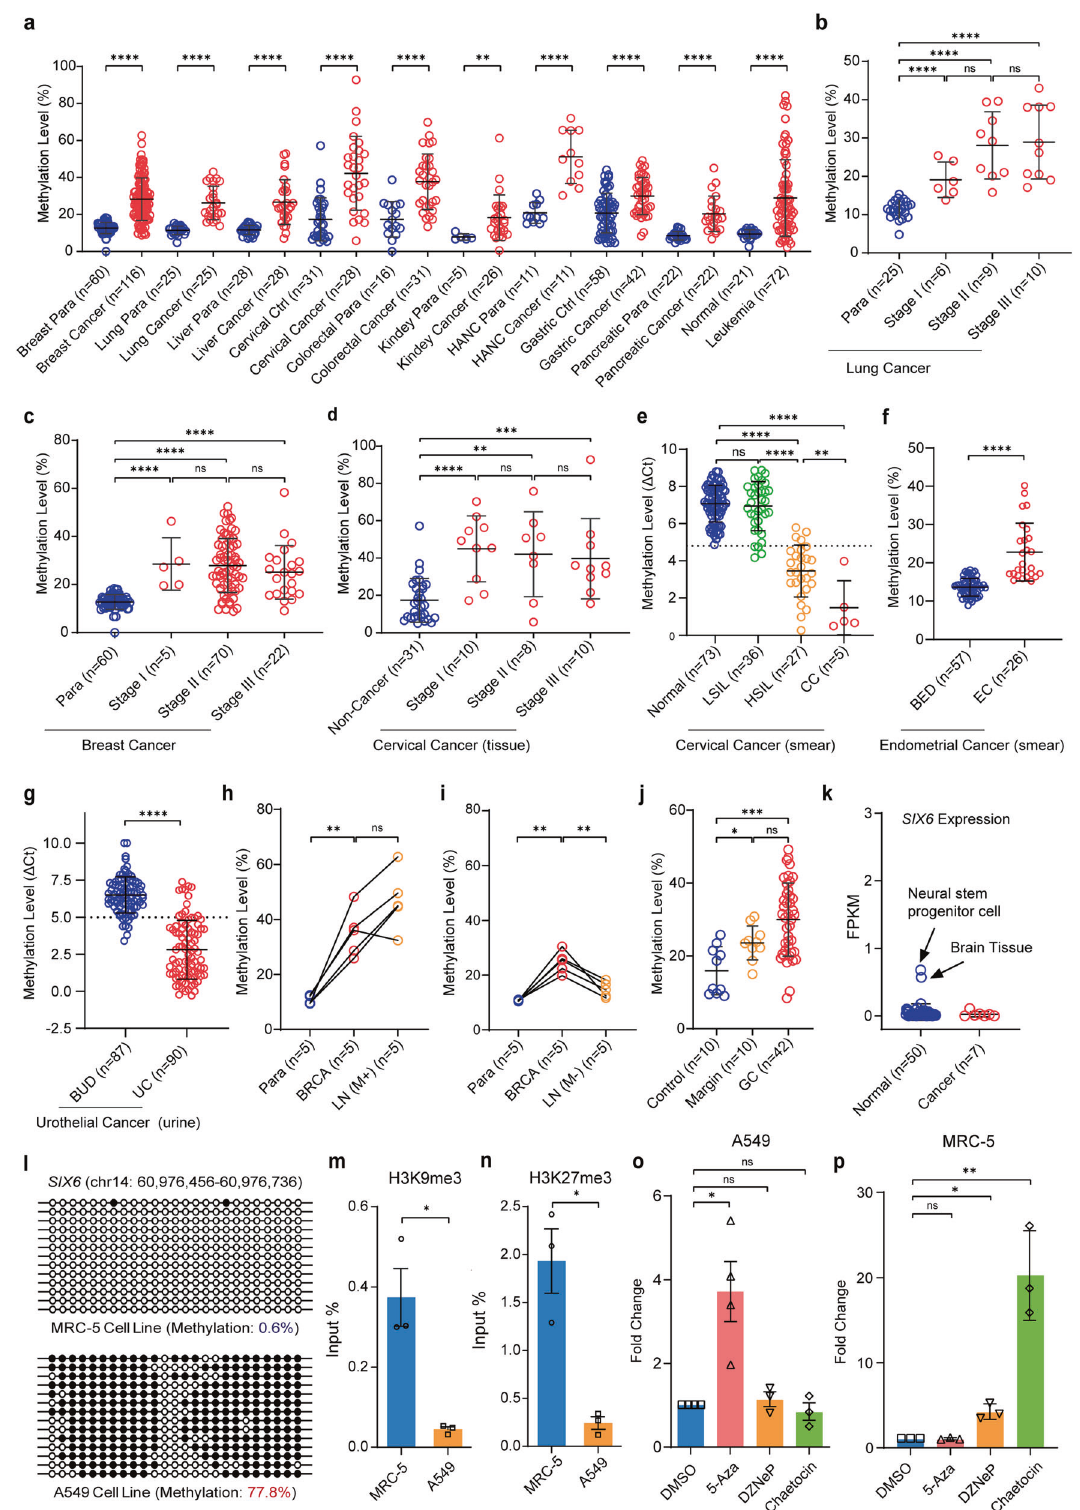
compared with A549 (Fig. 1m, n), but not active markers H3K4me1, H3K4me3, and H3K27ac (Supplementary Fig. S4b – d). Except for lung cancer, SIX6 was also silenced in bladder carcinoma cells T24 and normal bladder cell line CCC-HB-2 (Supplementary Fig. S4e). Similarly, signi fi cant hypermethylation and H3K27me3 enrichment were observed in T24 and CCC-HB-2, Signal Transduction and Targeted Therapy (2022)